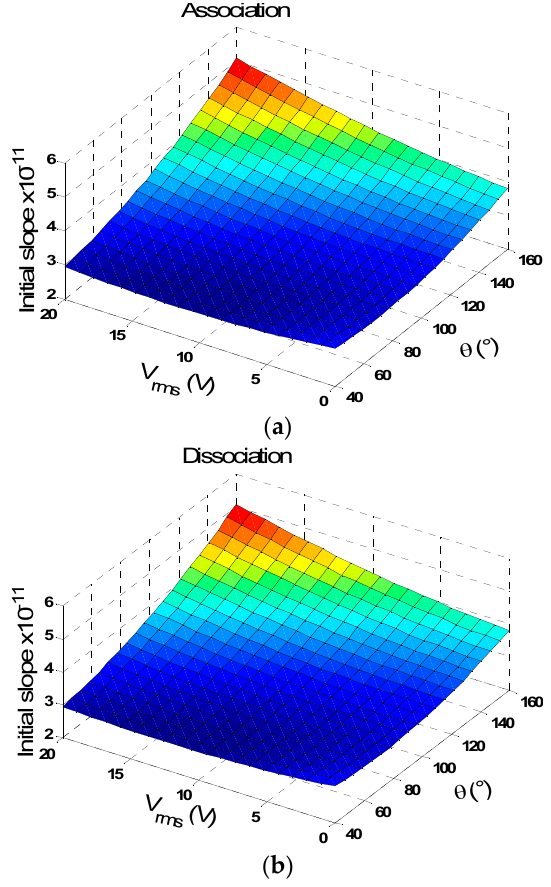
Figure 6. ( a ) Surface plot of initial slope related to the association and ( b ) dissociation stages versus applied voltage V rms and the electrode aperture angle α = θ . The average inlet velocity is fixed at 100 µ m/s. The initial slope for the both phases varies linearly with the applied voltage. The maximum of the initial slope is reached for V rms = 15 V and α = θ = 160 ◦ .